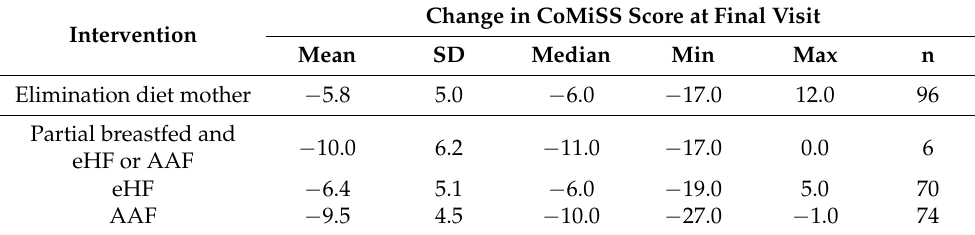
Table 10. Dietary intervention and change in CoMiSS.